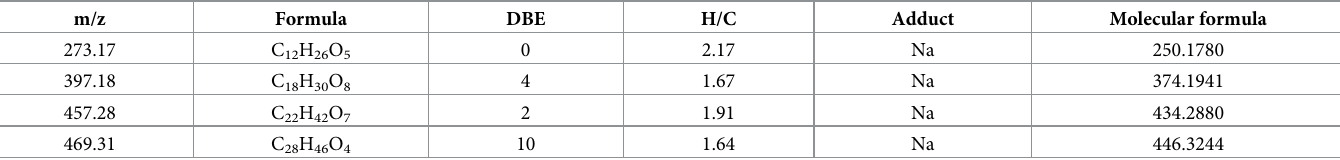
Table 1. Peaks increasing for oil